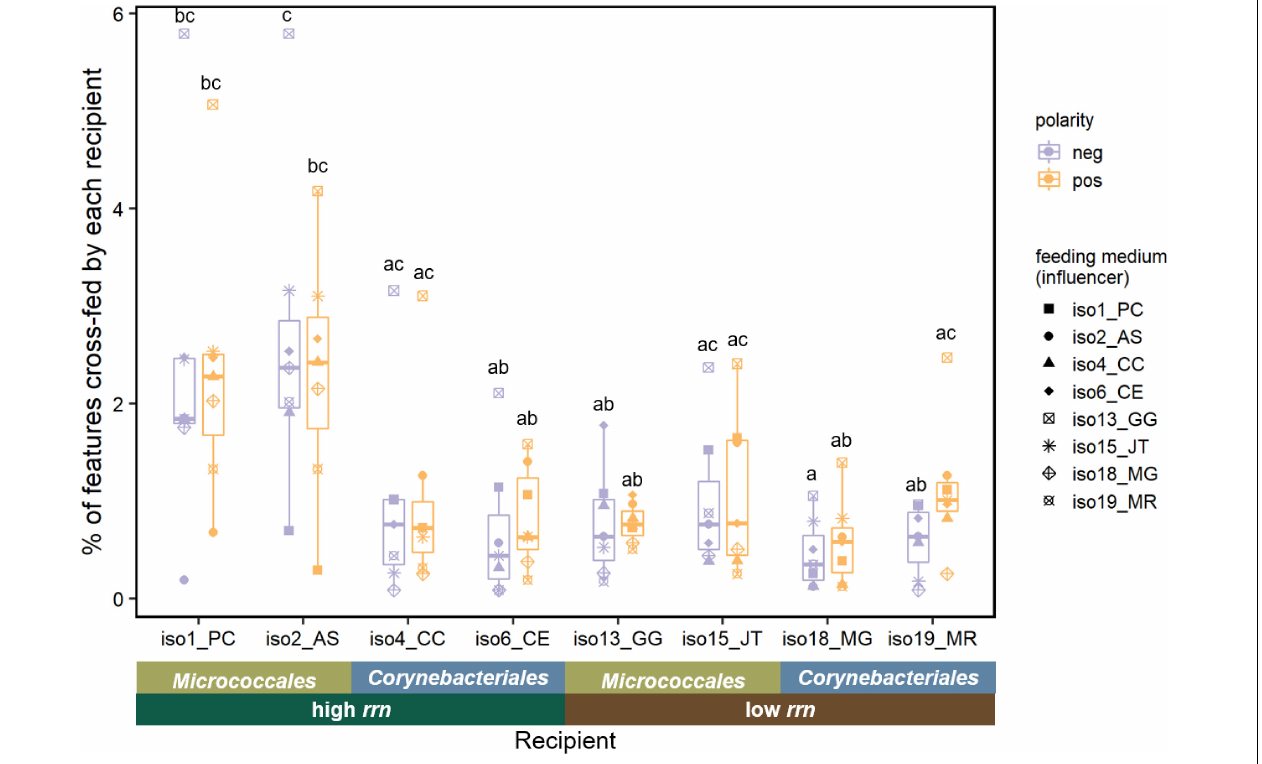
FIGURE 5 | Percentage of LC-MS features cross-fed by each recipient isolate. Significant differences denoted using letters ( p < 0.05, one-way ANOVA with post hoc Tukey HSD test). n = 7 for each recipient isolate under each ionization mode. Each data point represents the percentage of positive or negative features depleted by a recipient isolate grown on the spent medium of an influencer (corresponding to different shapes listed in the legend). An ANCOVA revealed that taxonomic group and its interaction with rrn copy group both had significant effects on the percentage of cross-feeding features depleted by the recipient isolate, under both polarities as well as the average result ( p < 0.05). Feature count results can be found in Supplementary Table 5